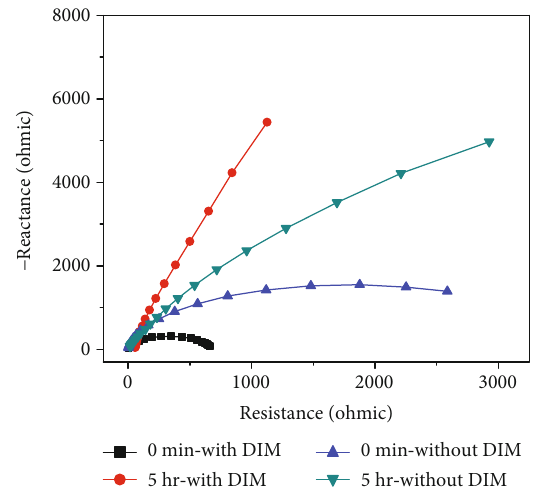
Figure 14: Cole-Cole plots of the PCDTBT:PC processed with and without 3% DIM of pristine and 5hr irradiated